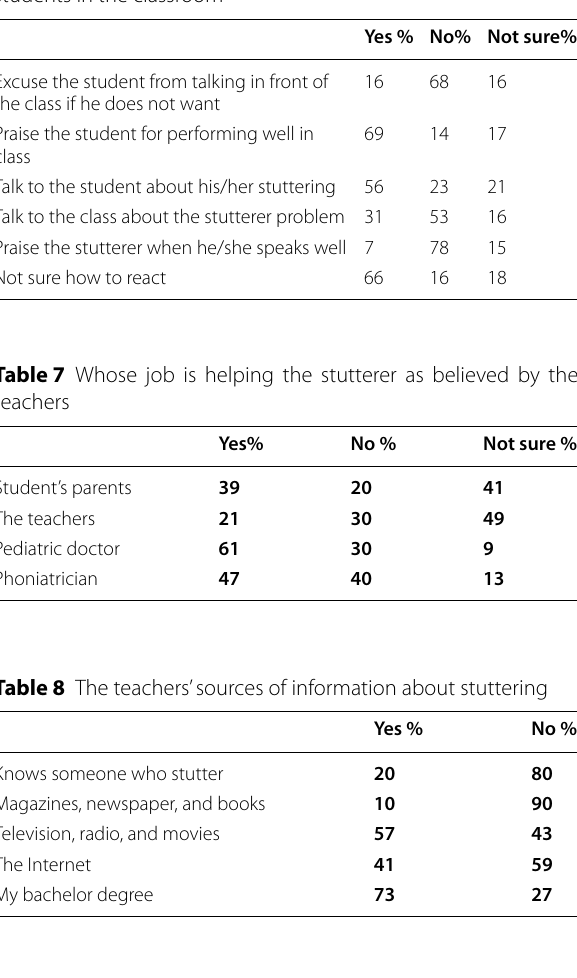
Table 6 The teachers’ strategies for dealing with stutterer